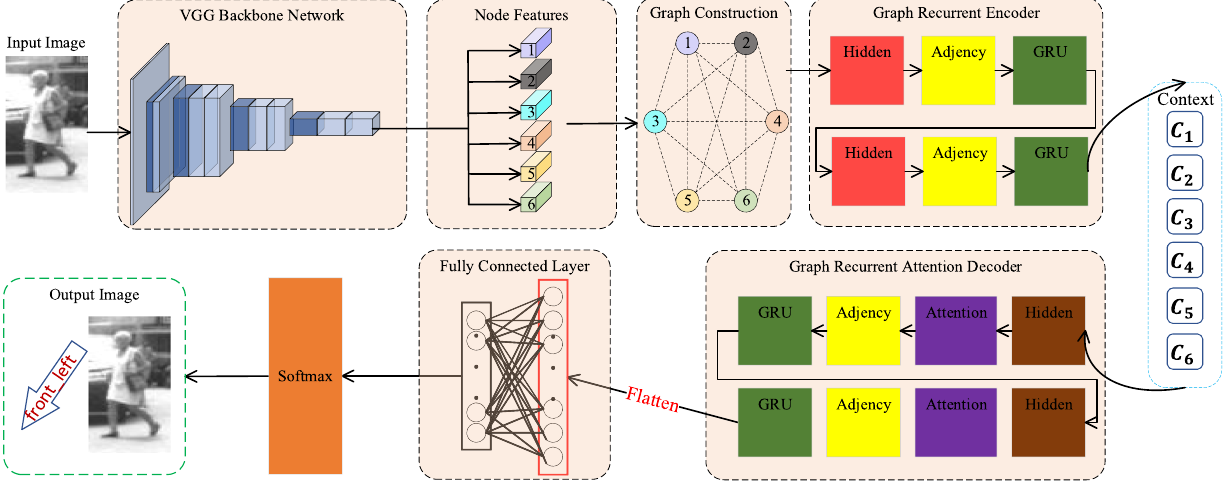
Neural Network (DCNN) for object orientation estimation, but their method is aimed at multiple objects, including not only pedestrians but also cars. Beyer et al. [23] proposed a method based on CNN, which learns on simple labels, but only regresses the orientation of the head. Kumamoto et